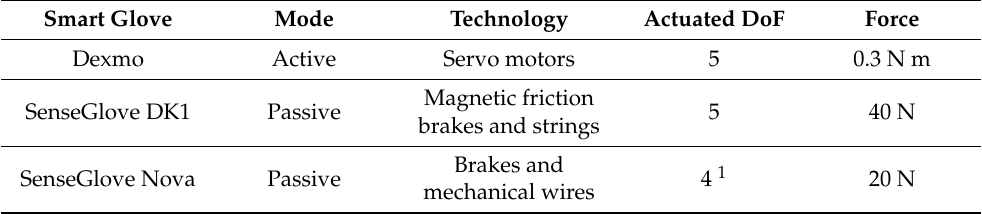
Table 6. Commercial smart gloves for kinesthetic